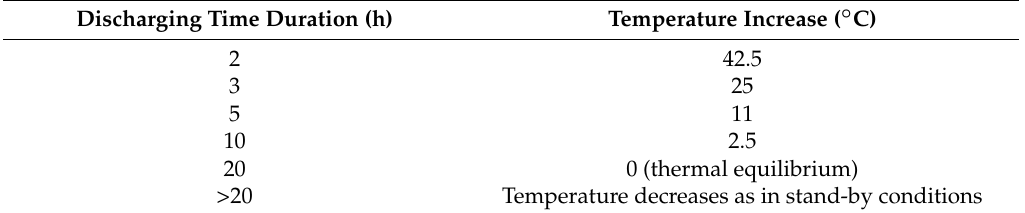
Table 3. Equivalent representation of the battery temperature increase depending on the discharging time duration (values are coherent with Figure 2b). In the case where the discharging time duration overpasses 20 h, the battery thermally behaves as in stand-by